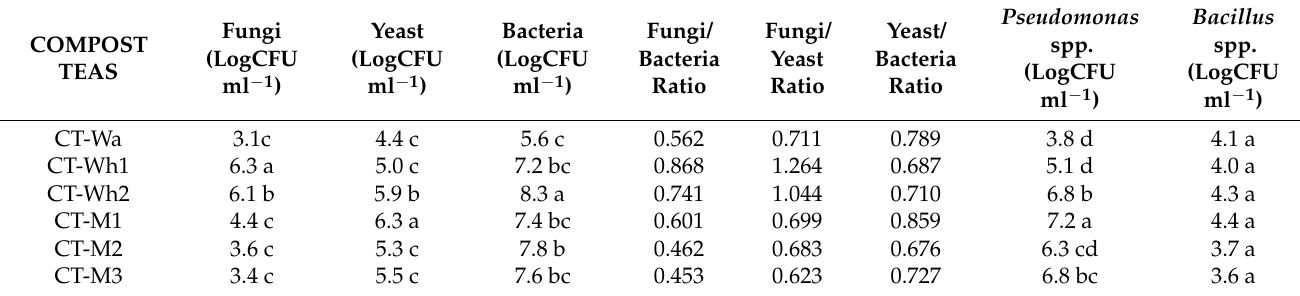
Table 6. Microbiological features of the final CTs. Values followed by different lowercase letters were significantly ( p ≤ 0.05)